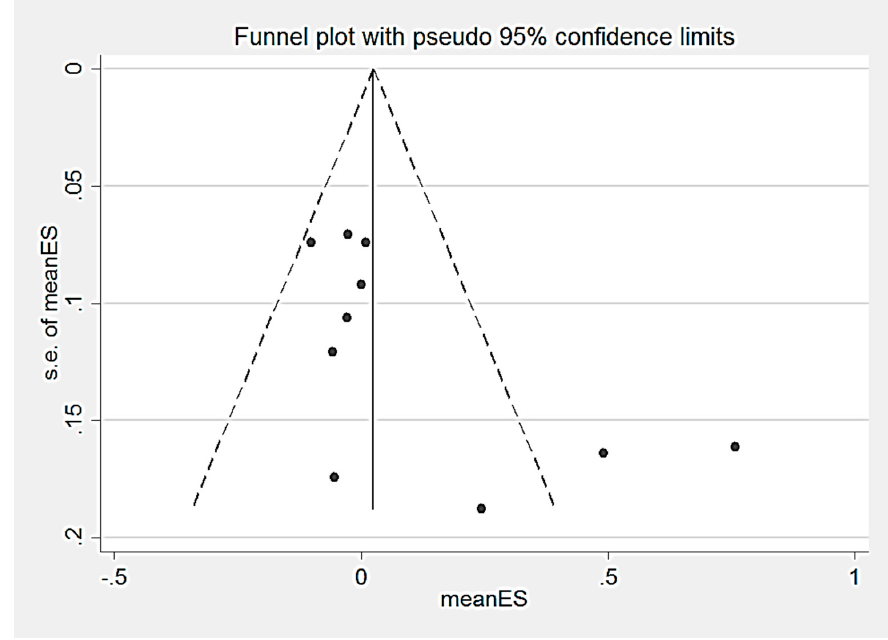
Figure 7. Funnel plot for child crystallized intelligence outcomes with 95% confidence limits. meanSE, mean standard error.